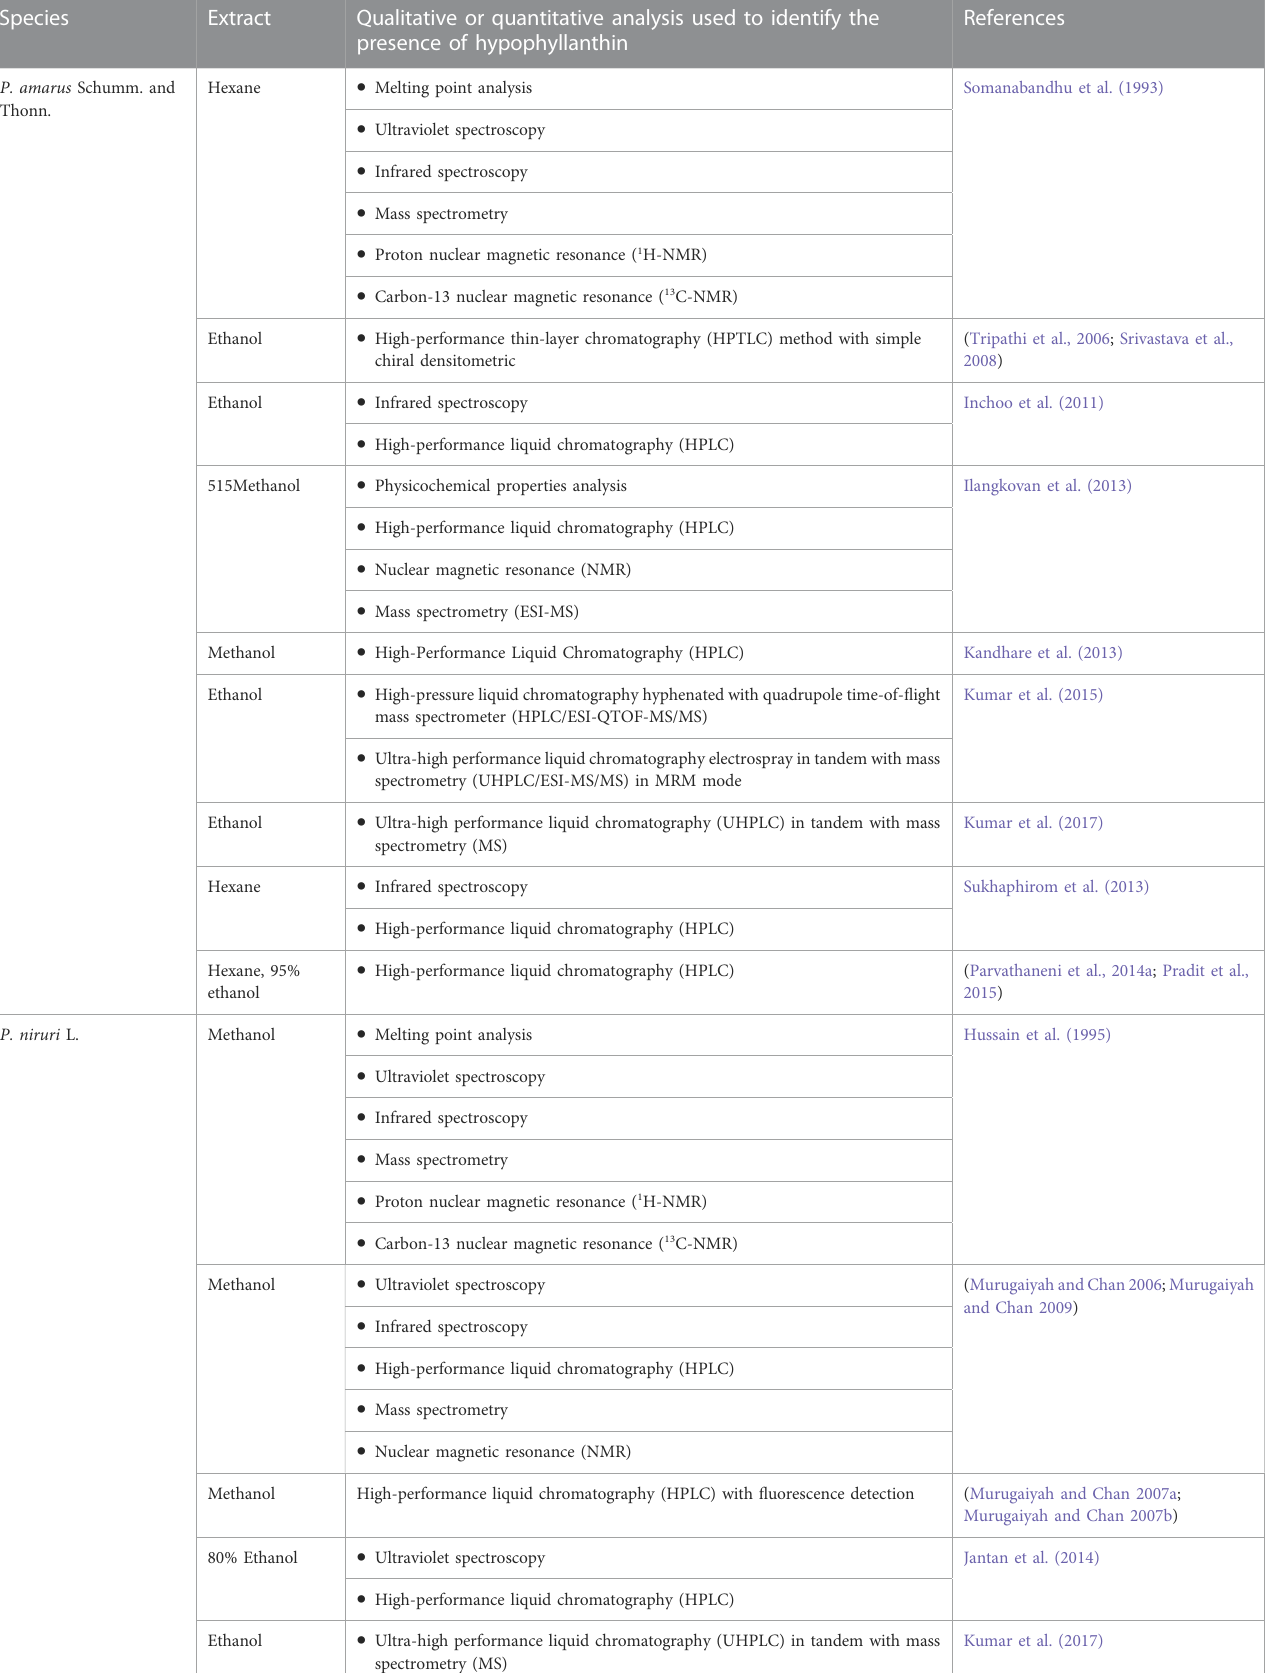
TABLE 1 Summary of qualitative and quantitative analysis of hypophyllanthin.